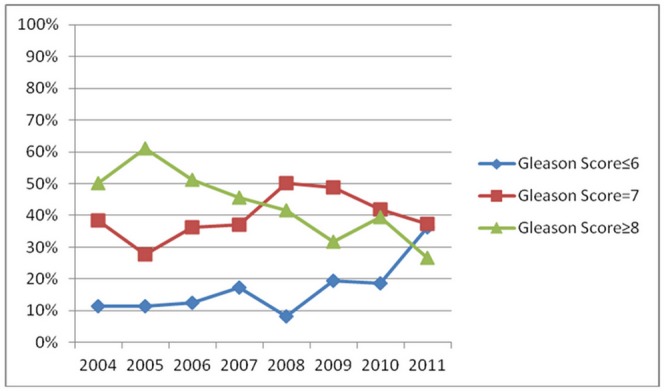
Trends of Gleason Score ≤6,  = 7, ≥8 Groups over the years.The percentage of ≥8 group trend to go downwards from 50% in 2004 to 27% in 2011 (Ptrend = 2.08×10−7).